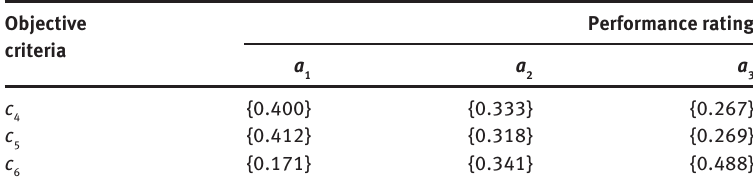
Table 3: The Normalized Performance Ratings under Each Objective Criterion. Objective